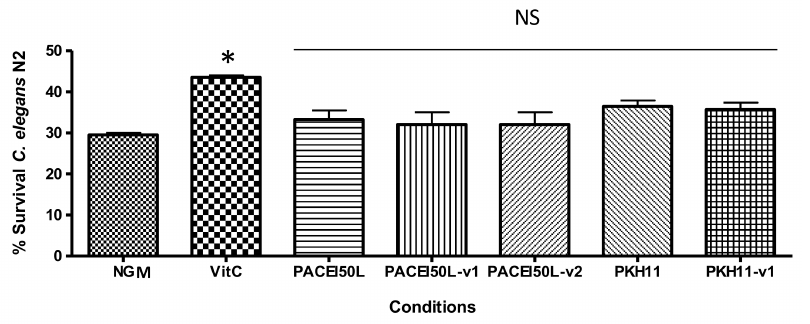
Figure 4. The percentage of C. elegans N2 survival after an acute oxidative stress with H 2 O 2 . Nematodes were cultured in control conditions (NGM), with vitamin C (10 µ g/mL) and with peptides (0.1 µ g/mL). * Significantly different from the control ( p < 0.05; one-way ANOVA followed by Tukey’s HSD); NS: not significant ( p >